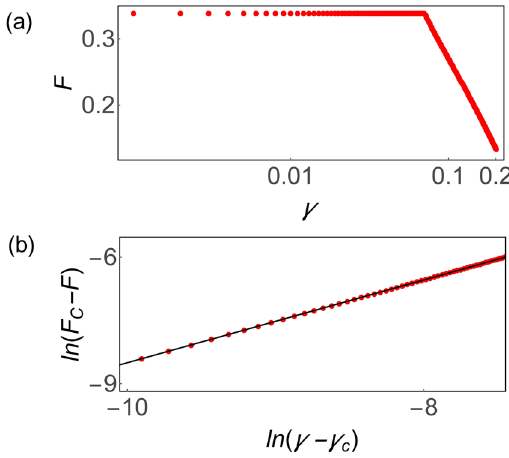
Figure 2. Multipartite entanglement in non-Hermitian phase transition. ( a ) Quantum Fisher information F as a function of the control parameter γ in the non-Hermitian LMG model for N = 40 spins. ( b ) Scaling of quantum Fisher information near the non-Hermitian phase transition point. The vertical axes is − F F ln( ) with C F C being the quantum Fisher information at the critical point and F the quantum Fisher information near the critical point and the horizontal axes is γ γ − ln( ) . The red solid circle presents the numerical exact solution and c the black solid line is the linear fitting line, where the slope is 0.98 ±